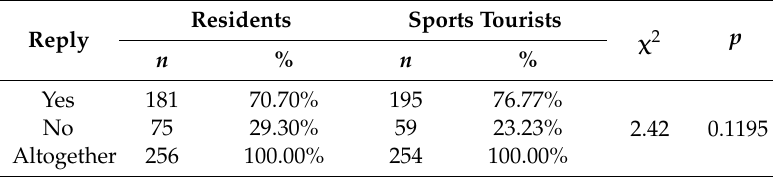
Table 8. Study about the motivation to undertake PA due to cheering in the 6th Poznan Half Marathon—depending on the place of the residence.